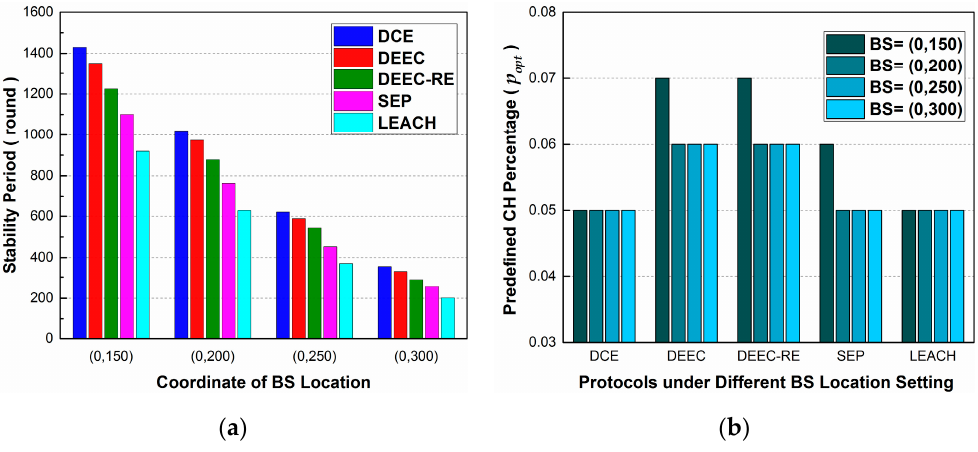
Figure 7. The effect of altering BS location on stability period in Scenario 4: ( a ) The best stability period achieved under different settings of BS location; ( b ) The corresponding p opt where the longest stability period is achieved.